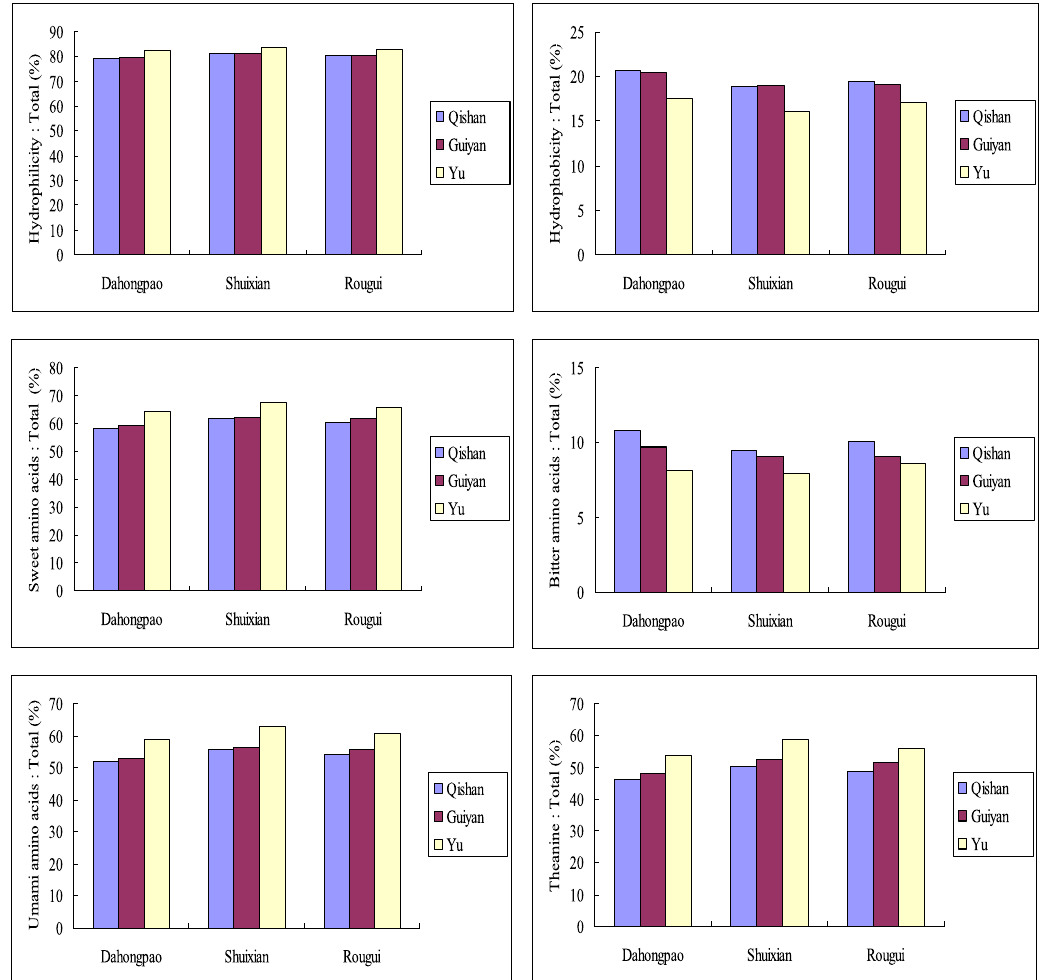
Fig. 4: The percentage of characteristic amino acids in tea leaves of the different plantations. Hydrophilic amino acids including threonine, lysine, serine, glycine, cysteine, tyrosine, histidine, arginine, asparagine, glutamic acid, and theanine. Hydropholic amino acids including alanine, valine, leucine, isoleucine, proline, phenylalanine, and methionine. Sweet amino acids including glutamic acid, alanine, glycine, and theanine. Bitter amino acids including valine, leucine, and isoleucine. Umami amino acids including glutamic acid and